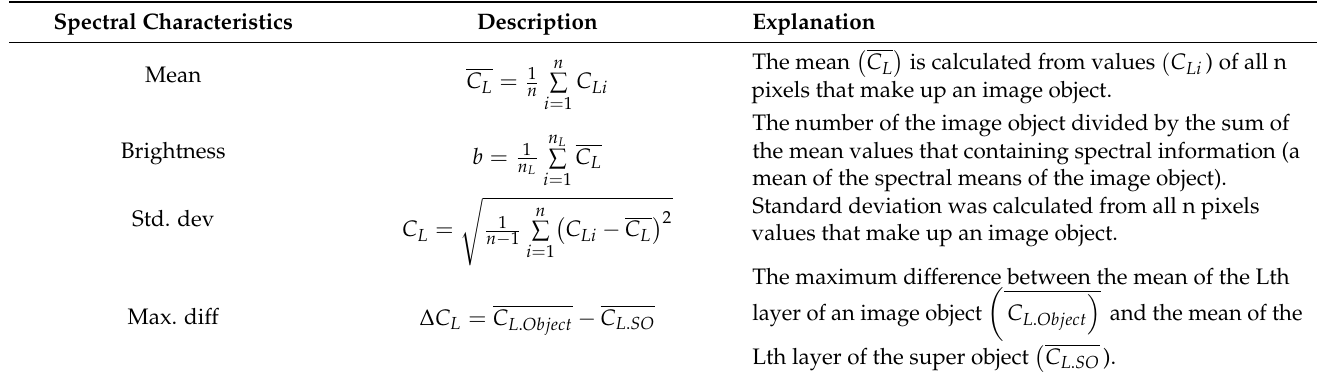
Table 2. A feature space set of spectral index characteristics.